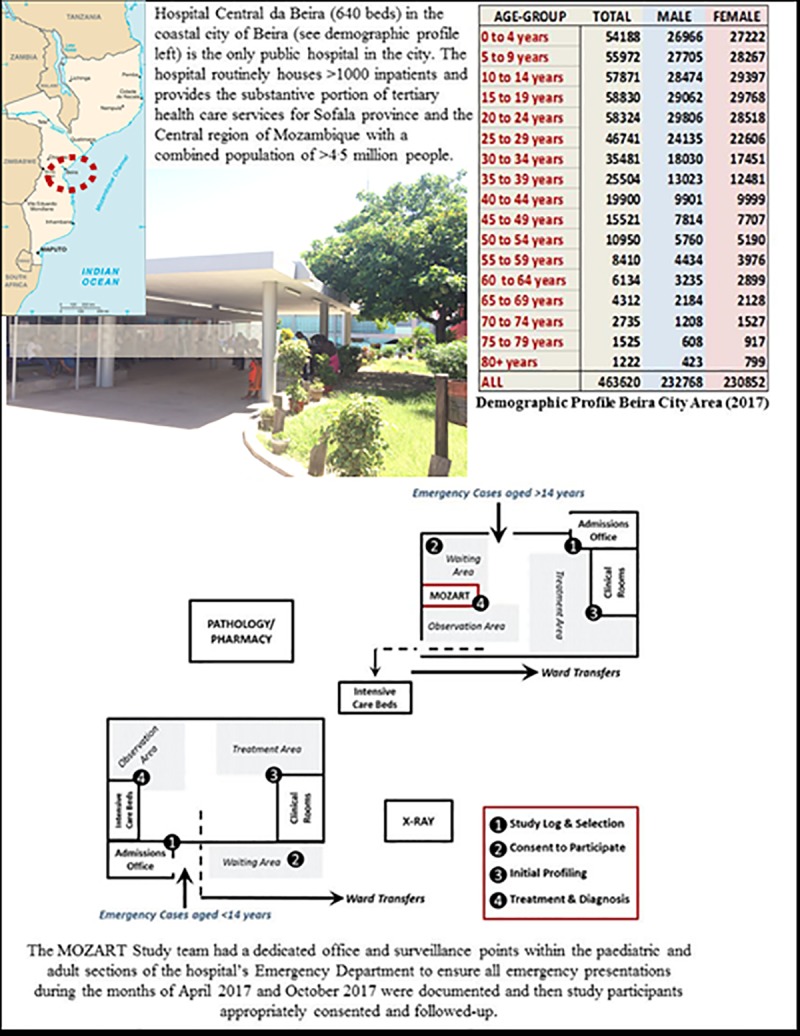
Hospital Central da Beira (640 beds) in Beira (Central Mozambique).Public domain map of Mozambique sourced from: https://www.drivingdirectionsandmaps.com/mozambique-google-map/ (Accessed May 2019).